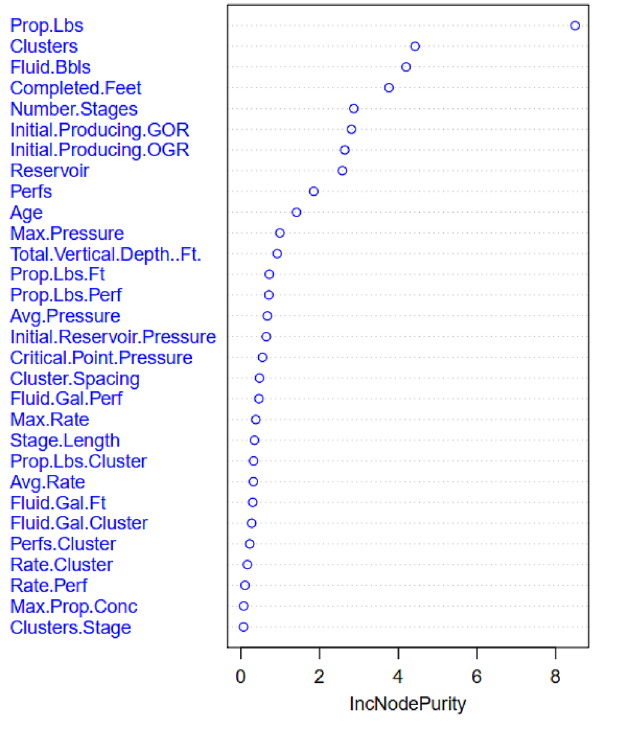
Fig. 2 The second measure of importance calculated from regression